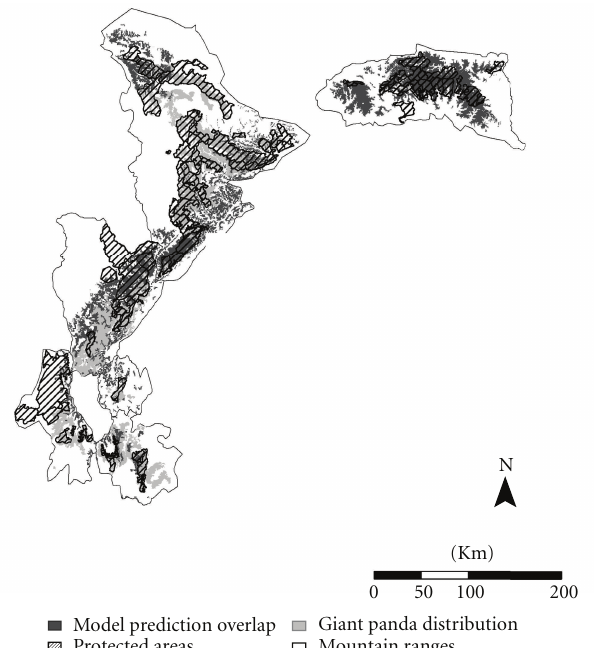
Figure 3: Spatial agreement for predictions of suitable habitat in 2080 based on the Canadian Centre for Climate Modeling and Analysis Coupled Model version 3 and the Hadley Center for Climate Modeling Coupled Model version 3, the current giant panda distribution, and protected status based on the existing protected area